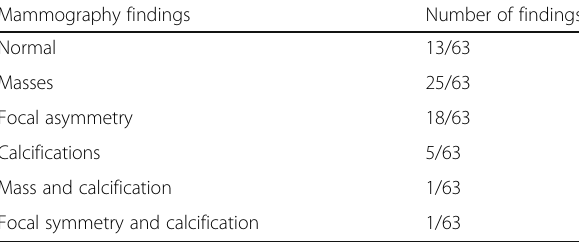
Table 2 Mammography findings among the studied population Mammography